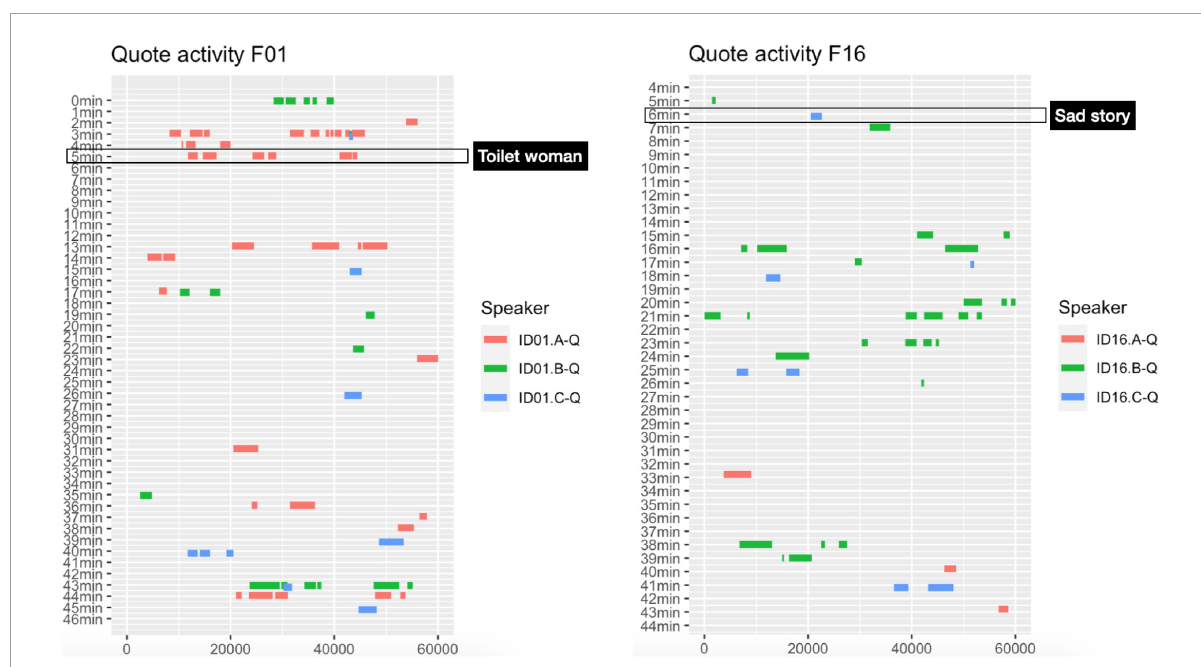
FIGURE2 Quote activity in the two files F01 and F16 from which “Toilet woman” and “Sad story” were